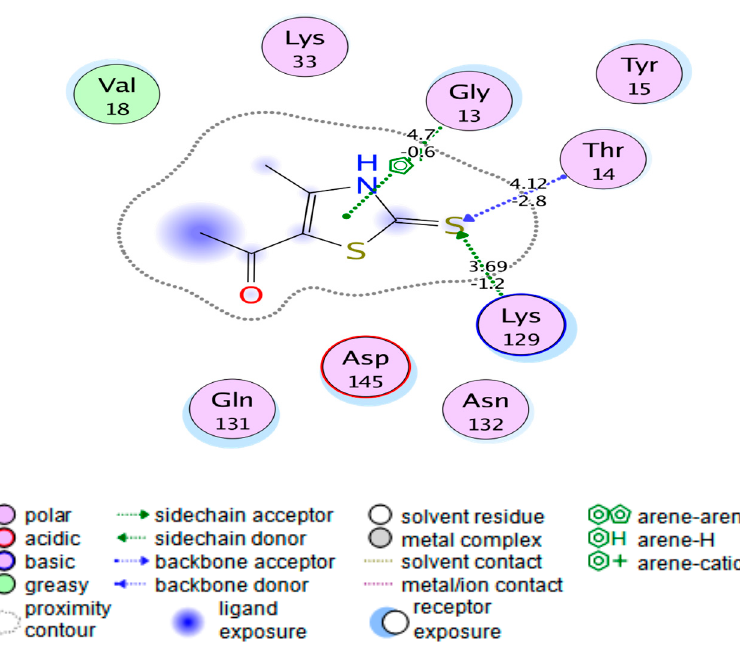
Figure 3. Thiazoline 2c into the binding pocket of CDK 2 enzyme showing the binding energies and interactions with amino acid residues.